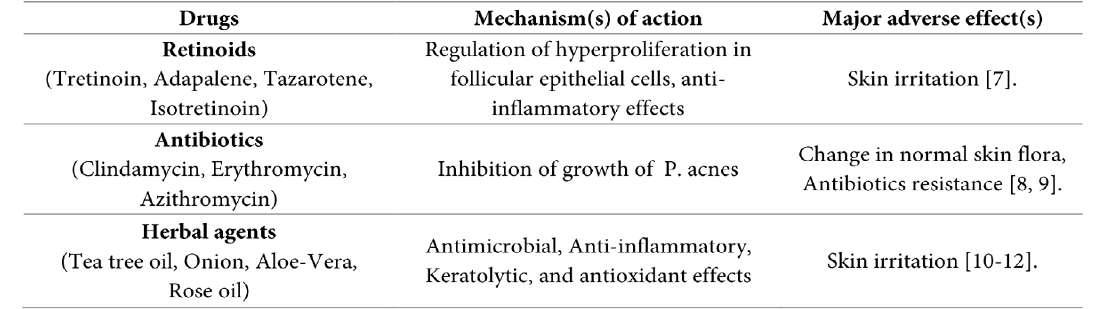
Table1. Topical drugs that are commonly used for acne